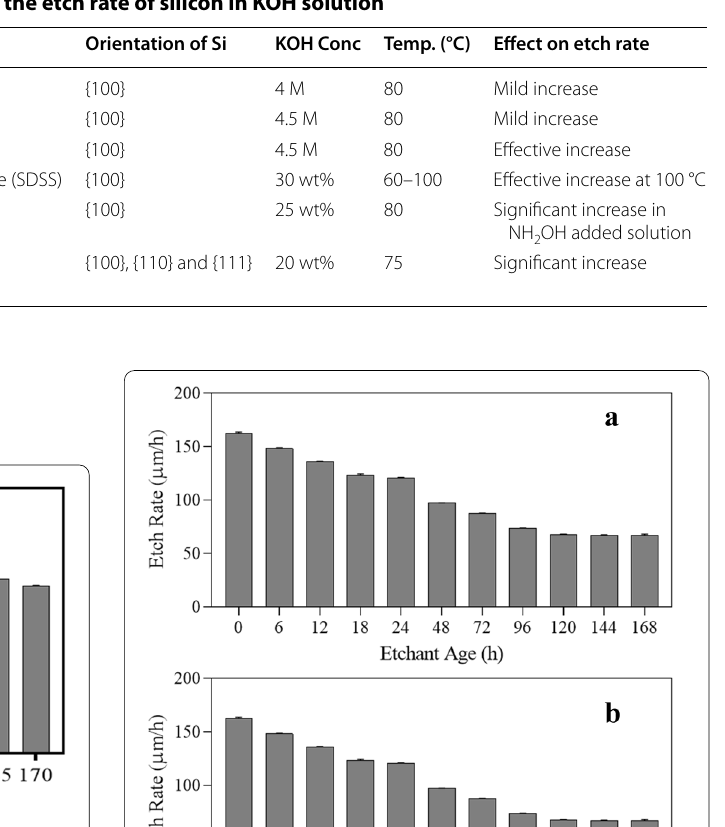
Fig. 31 Effect of aging of 15% NH 2 OH rates of (a) Si{100}, (b) Si{110}, and (c) Si{111} at 75